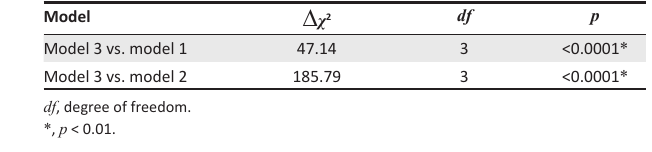
TABLE 4: Difference testing for changes in χ 2 in competing structural models.